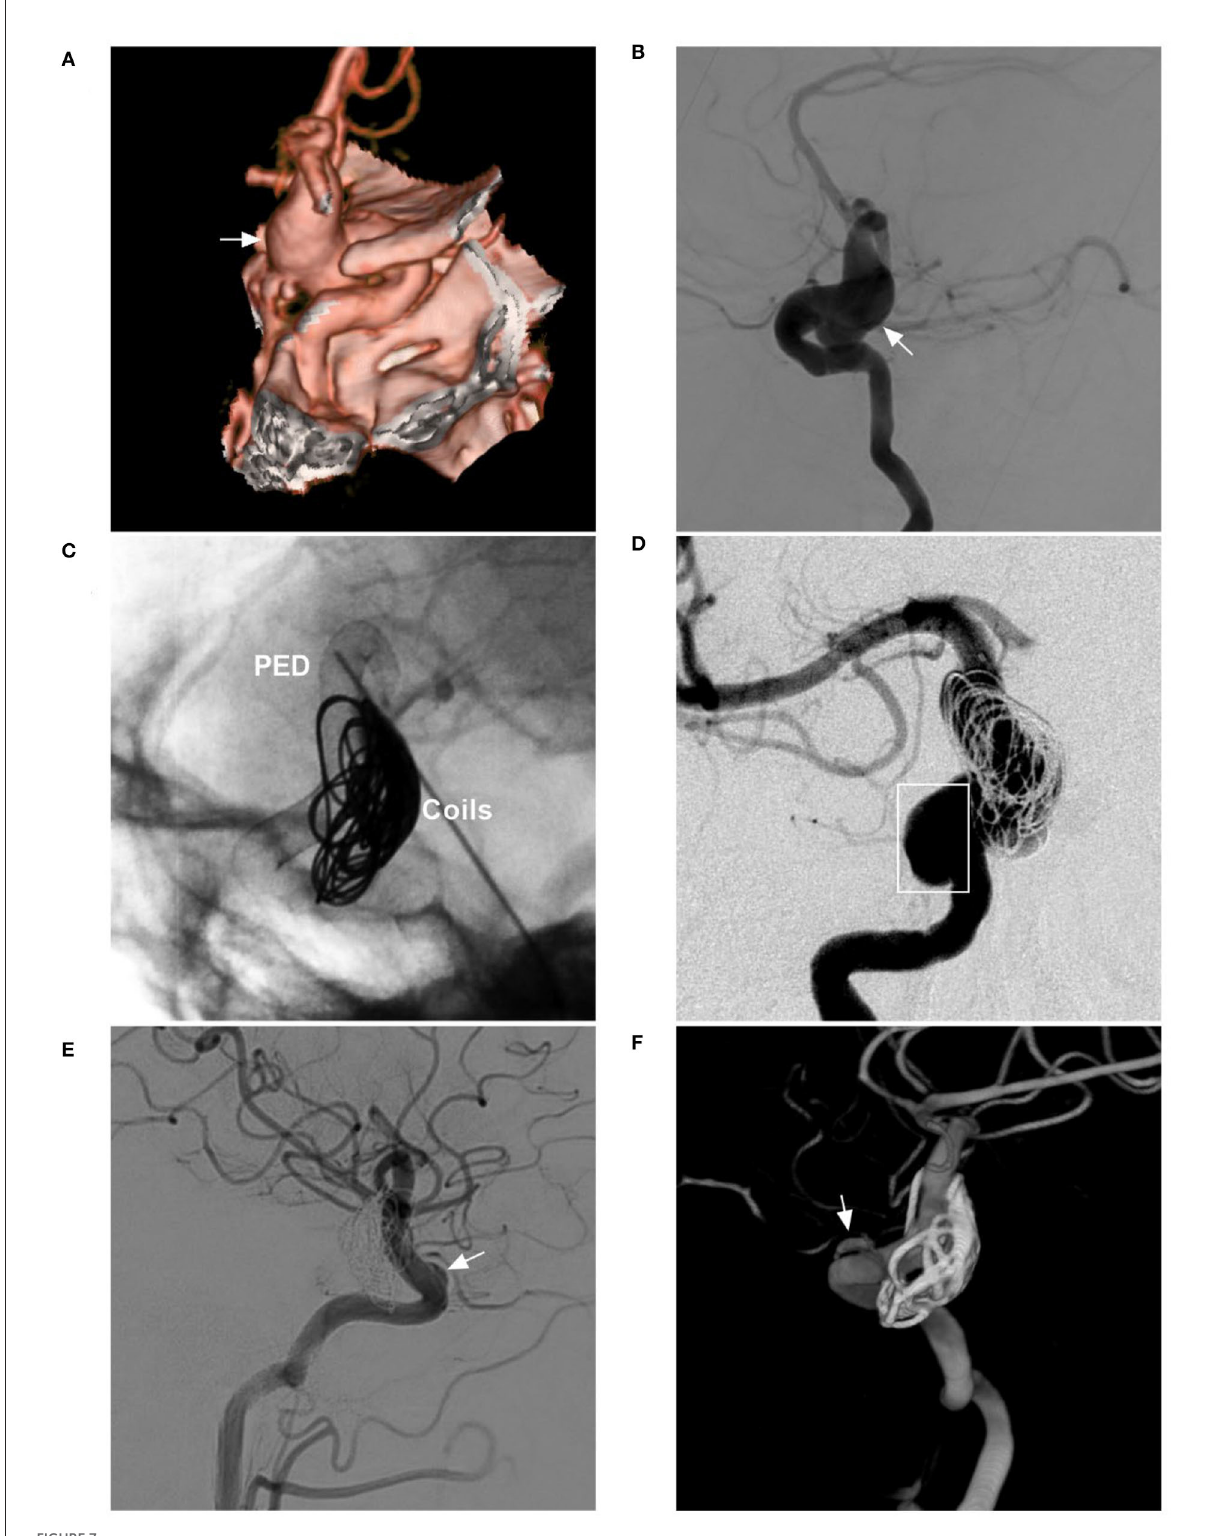
FIGURE7 FDS deployment in a fusiform aneurysm under coiling assistance. (A,B) CTA (A) and DSA (B) show a large fusiform aneurysm (arrows) of the paraophthalmic segment. (C) X-ray shows the FDS deployment (PED) under the assistance of coiling (coils). (D) Postoperative DSA shows that the distal part of the aneurysm was coiled, and the proximal part (frame) was left. (E,F) Follow-up DSA at 6 months (E) and three-dimensional